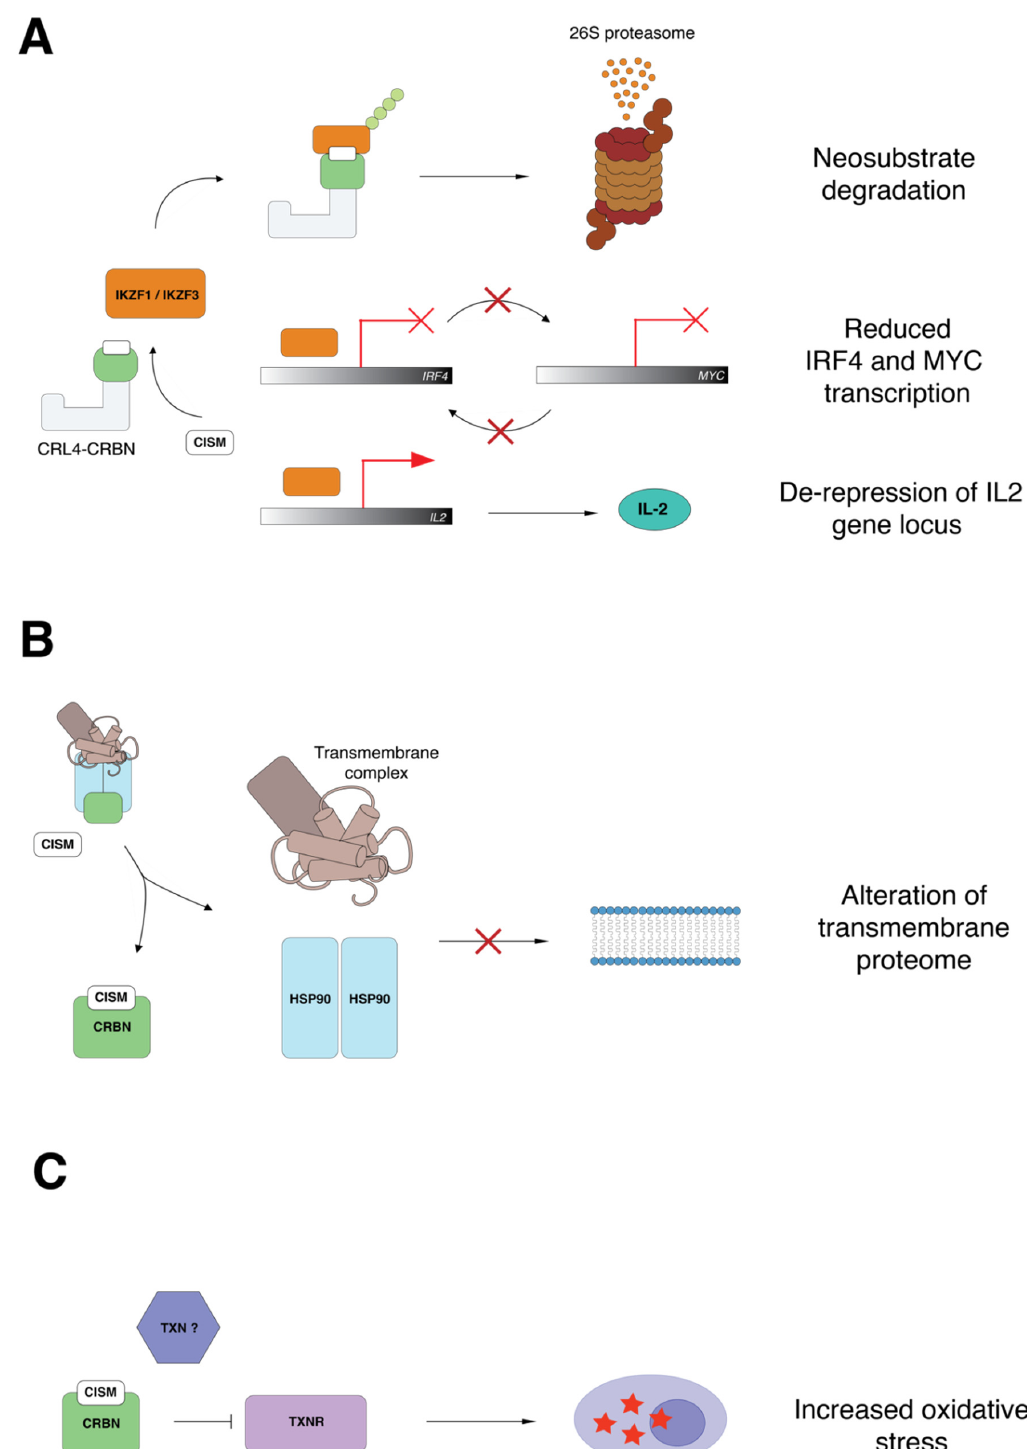
Figure 1. Pathways that are modulated by immunomodulatory imide drugs (IMiDs) with therapeutic significance in multiple myeloma (MM). ( A ) Proteasomal degradation of Ikaros (IKZF1) and Aiolos (IKZF3) following IMiD treatment results in suppression of the IRF4-MYC transcriptional feedback loop. ( B ) CRBN is an HSP90 co-chaperone which facilitates the folding of transmembrane proteins, potentially modulating cell-to-cell interactions in the bone marrow microenvironment. ( C ) Lenalidomide binds Cereblon (CRBN) and interferes with neutralization of reactive oxygen species by disrupting the thioredoxin (TXN)-thioredoxin reductase (TXNR) axis.